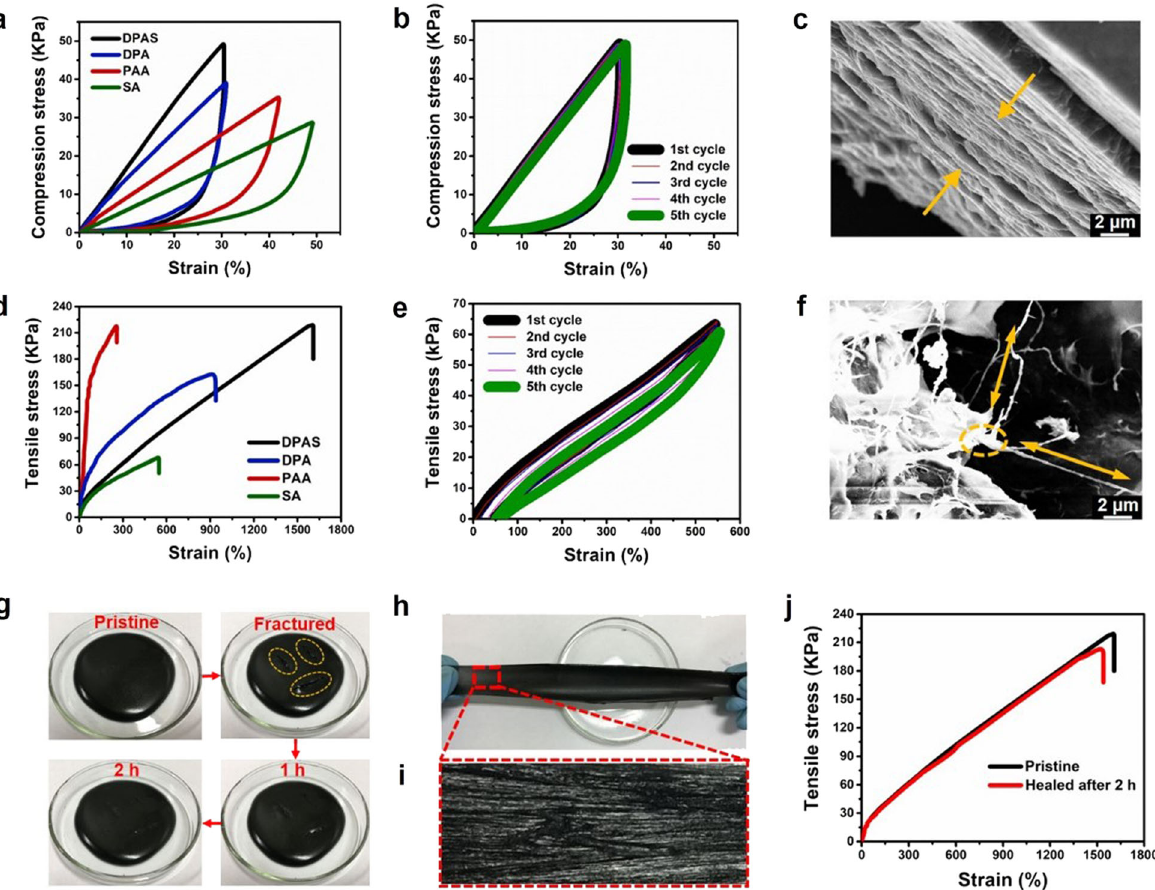
Fig. 3 Mechanical and self-healing properties of the hydrogels. a The compressive loading – unloading curves of various hydrogels. b The compressive loading – unloading curves of 5 cycles of DPAS hydrogel. c SEM image showing the layered stacking structure of the DPAS hydrogel in compression. d The typical tensile stress – strain curves of various hydrogels. e The tensile loading – unloading curves of fi ve cycles of DPAS hydrogel. f SEM image showing the micro fi bril structure of DPAS hydrogel when stretching. g Fracture-recovery test of the hydrogel. h Tensile images and i the corresponding stretch magni fi cation of the hydrogel after cutting and followed by self-healing for 2 h. j Tensile stress – strain curves of the original and healed hydrogel after healing for 2 h. (The hydrogels are expressed as DPA, DPAS, and DPAS@P-GOM gels, where DP, A, S, and GO indicate the hydrogels containing DACO- PDA@Pd NPs, acrylic acid, sodium alginate, and graphene oxide, respectively. For example, DPAS corresponds to the p(DACO-DA@Pd NPs- co -AA-SA)